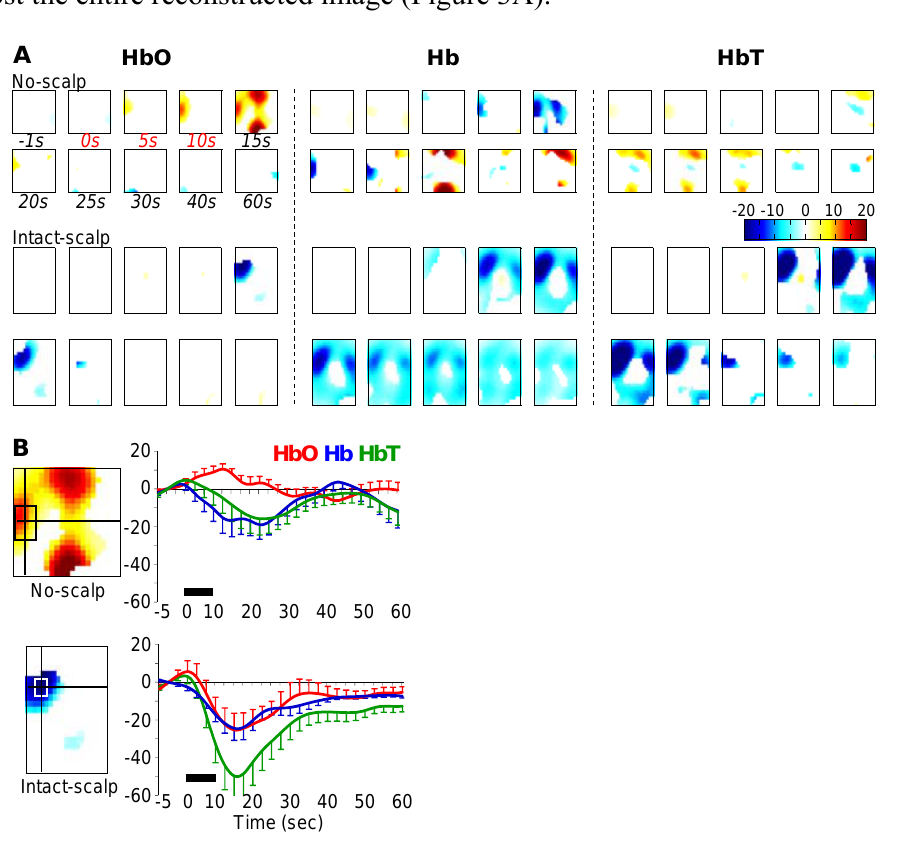
Figure 3. Pinching-induced hemodynamic changes in the no-scalp [12] and intact-scalp groups. ( A ) reconstructed images at typical time points. Unit: microMolar; ( B ) time series of hemodynamic changes at a center contralateral ROI. Locations of ROIs were determined in example images (left insets) at 15 s in HbO. Black bars: 10-s stimulation